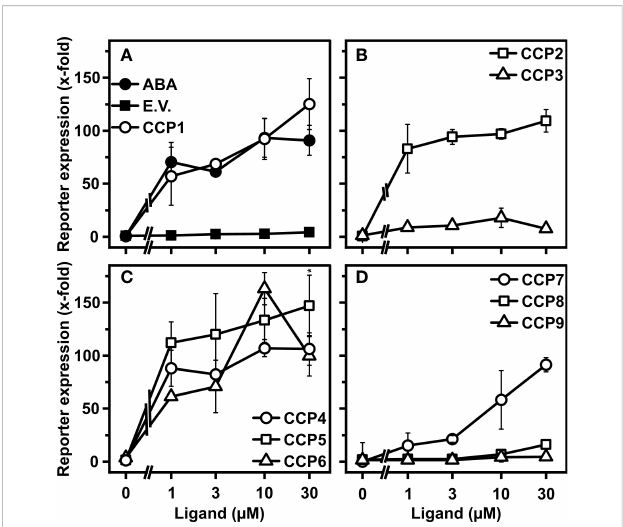
FIGURE 4 Regulation of ABA signaling in Arabidopsis cells by CCPs. (A – D) Arabidopsis aba2-1 protoplasts were analyzed for CCP-dependent induction of an ABA-responsive reporter. Protoplasts were transfected with DNA of several expression cassettes, including an ABA-responsive LUC reporter, a constitutively expressed GUS reporter gene for normalization, and the effector genes encoding RCAR11 and ABI2. The protoplasts were exposed to the ligands ABA and CCPs (symbols as indicated in A – D ) for 18 h prior to analysis of reporter expression. The ABA response was expressed as fold induction relative to the value of protoplasts transfected with empty vector for the RCAR11 expression cassette (E.V.; fi lled squares) in the absence of ligands, which was 2.8 × 103 relative light units per relative fl uorescence. Each data point represents the mean ± SD of three independent transformations plus three technical replicates per data point. (C) *P < 0.05 (one-way ANOVA) comparing reporter induction achieved by 30 mM CCP5 to that of 30 mM